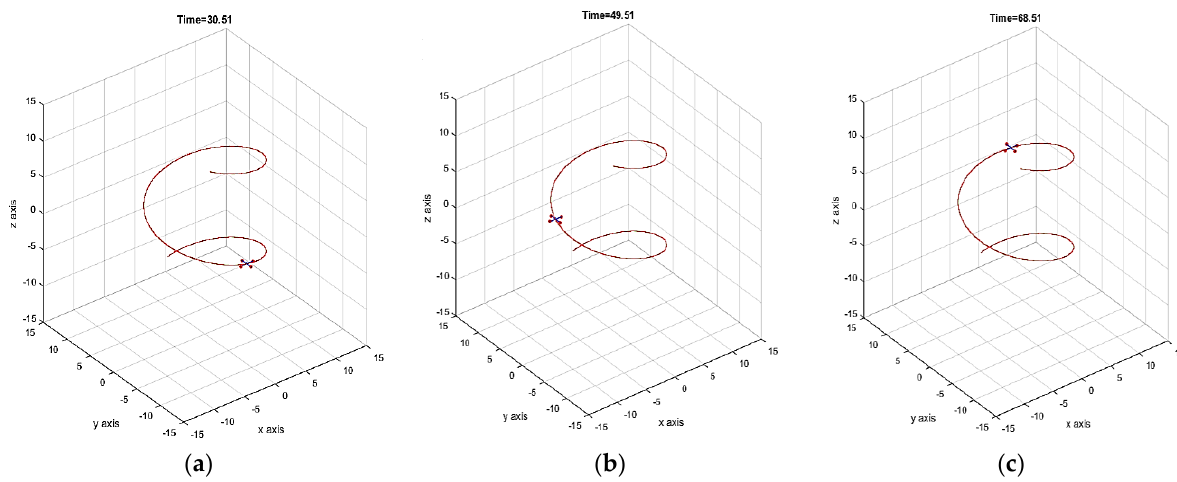
Figure 18. Quadrotor following helical trajectory using MFSDF-SMC control design.